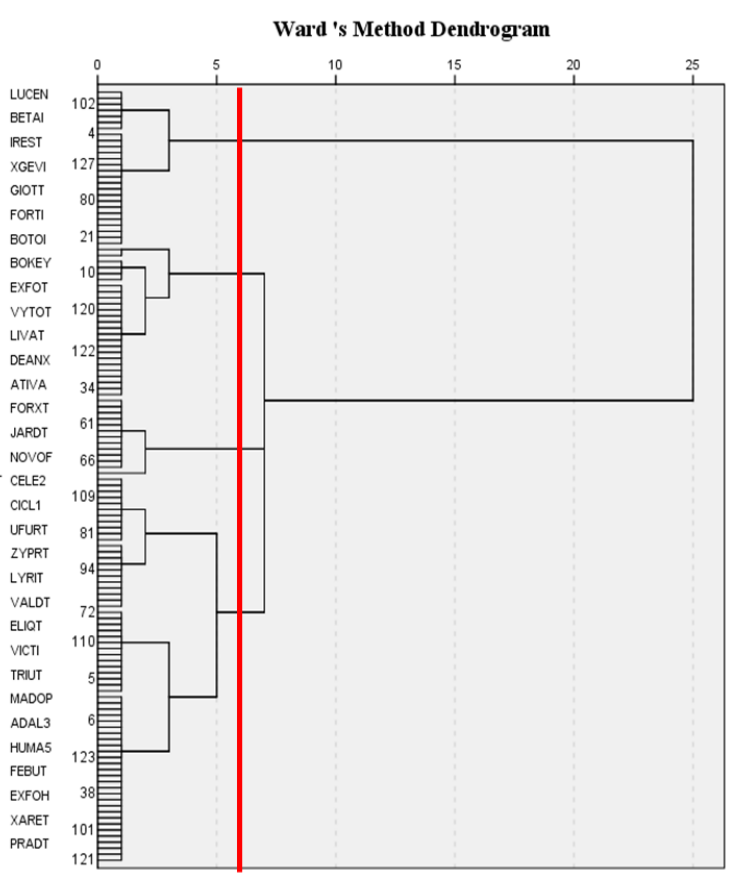
Figure 5. Using Ward’s method for hierarchical clustering.